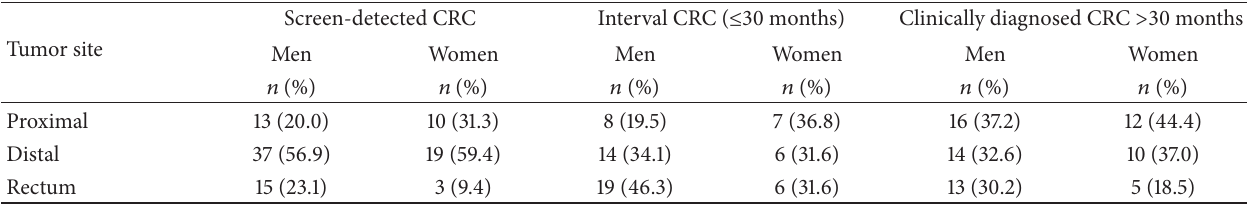
Table 5: Distribution of screen-detected and clinically detected CRC according to tumor site and gender. Tumor